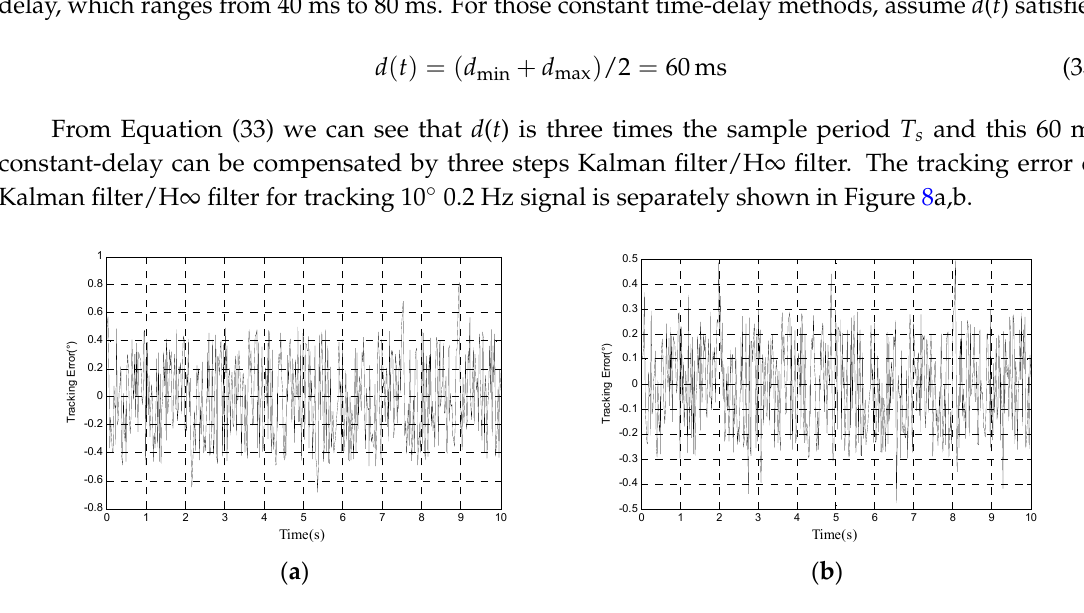
Figure 8. ( a ) Tracking error of Kalman filter when when tracking 10° 0.2 Hz signal; and ( b ) tracking error of H ∞ filter when when tracking 10° 0.2 Hz signal.